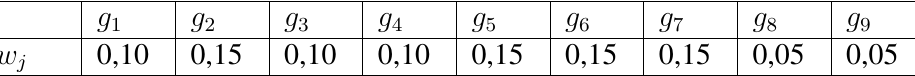
Table 1: Criteria weights w